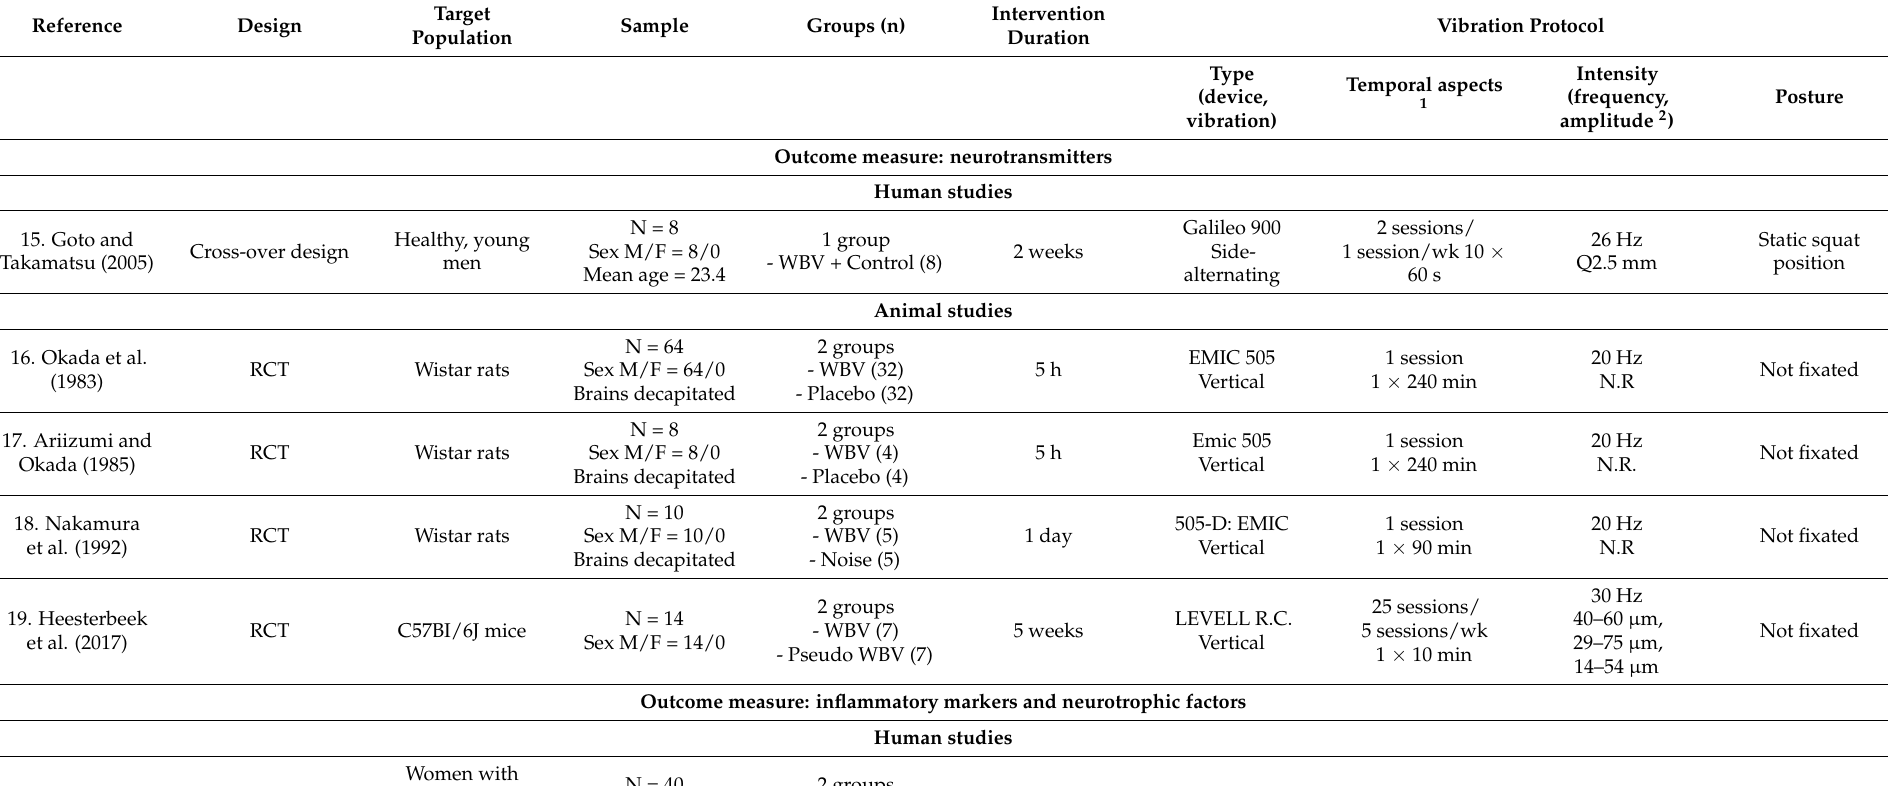
Table 3. General overview of study characteristics regarding potential ameliorating effects of WBV on neuropathological mechanisms of PD in animals and humans (N = 18